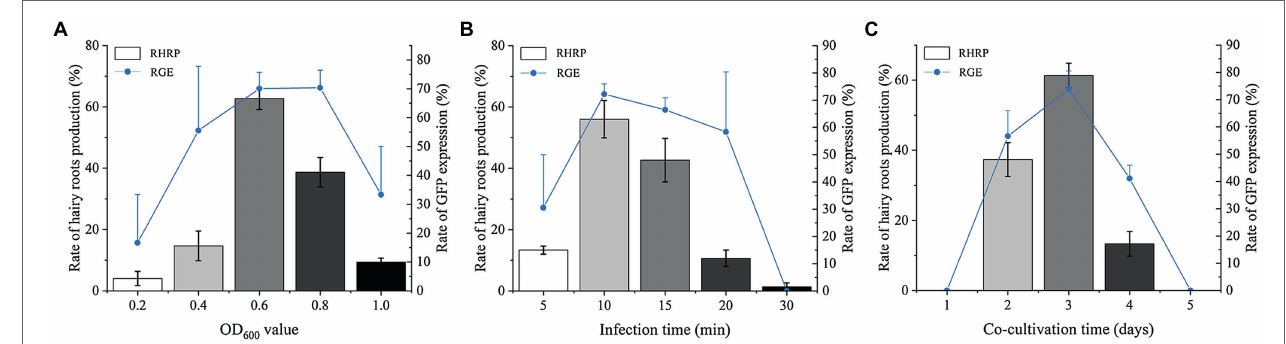
FIGURE 2 | Factors affecting the transformation efficiency of S. miltiorrhiza explants. (A) Effect of optical density on RHRP and RGE at 0.2, 0.4, 0.6, 0.8, and 1.0 OD 600 . (B) Effects of infection time on RHRP and RGE for 5, 10, 15, 20, and 30 min. (C) Effects of co-cultivation time on RHRP and RGE for 1, 2, 3, 4, and 5 d. Results are expressed as mean ± standard error. RHRP (%) = (The number of hairy roots with lengths ≥ 1 cm/the number of infected explants) × 100%. RGE (%) = (The